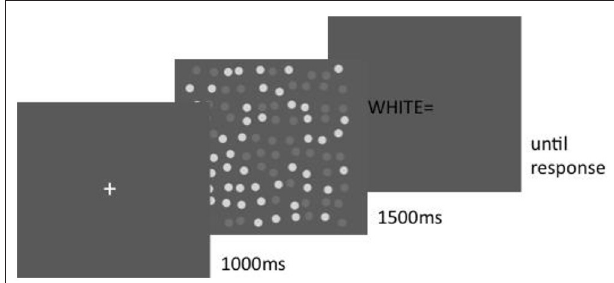
FIGURE 3 | Post-cue intermingled display. A verbal prompt as to which disk set to enumerate was given after the display until the subject entered his or her response.